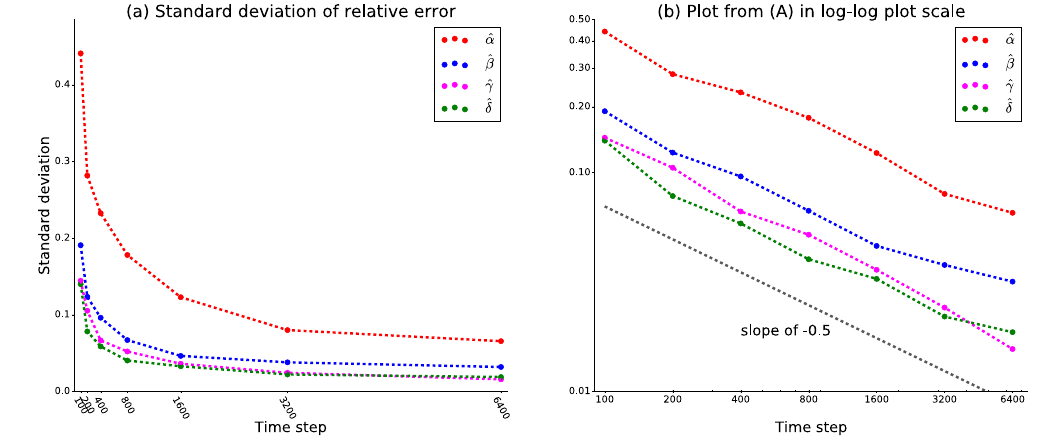
Figure 3. Comparison of standard deviation of relative error of parameter recovery. We use seven simulation time intervals: 100, 200, 400, 800, 1600, 3200 and 6400 time steps. There are 56 houses. Using parameter values shown in Table 2, parameter recovery was run on 50 different historical datasets generated by simulations with different seeds for random number generator. The plots show standard deviation of the relative error of recovered parameters averaged over 50 runs in linear scale ( a ) and logarithmic scale ( b